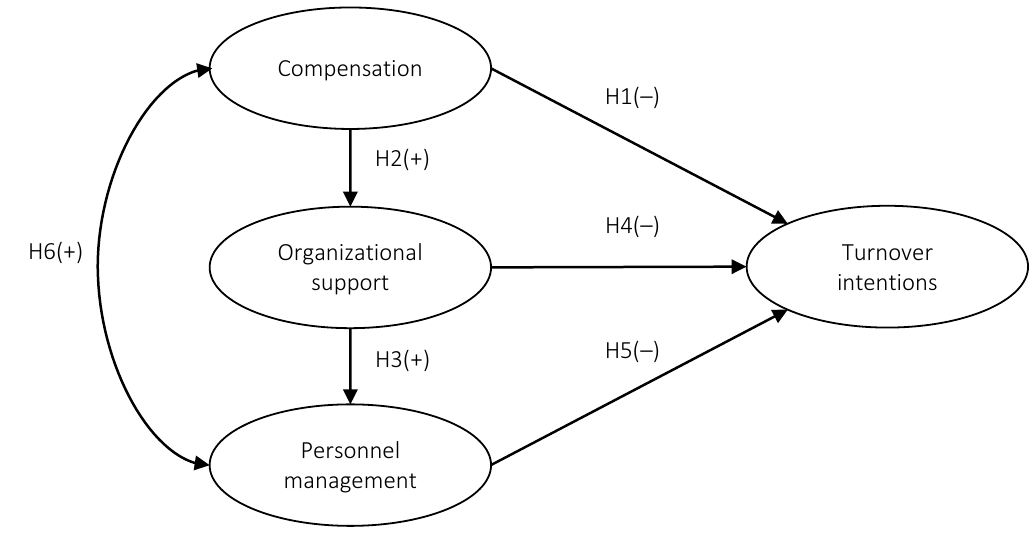
Figure 1. Research